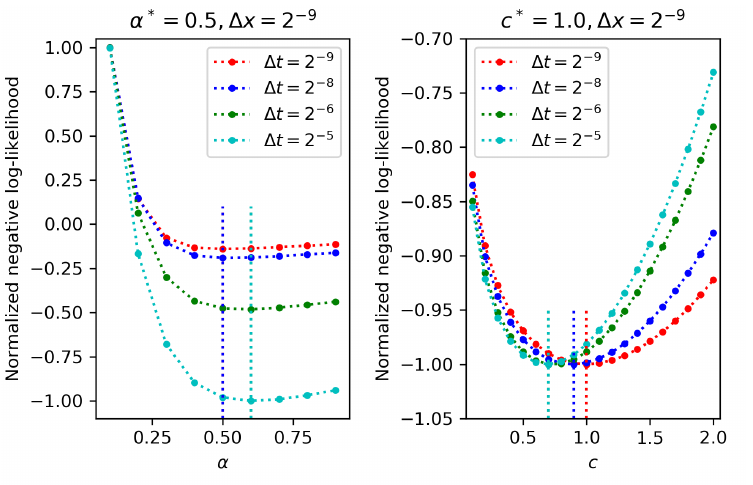
Figure 4. One-parameter estimation: Negative log-likelihood curves for varying α and fixed c ∗ = 1.0 ( left ) and for varying c and fixed α ∗ = 0.5 ( right ). The effect of temporal step on the optimal parameters is demonstrated. The noise magnitude is fixed to (cid:101) ∗ = 0.1. Full observation and partial observation curves are displayed in different colors. The spatial step is fixed to that of full observation, i.e., ∆ 0 x = 2 − 9 ; the temporal steps vary, and ∆ t = 2 − 9 corresponds to the full observation case, while the other three spatial steps correspond to partial observation cases with r t = 2,8, and